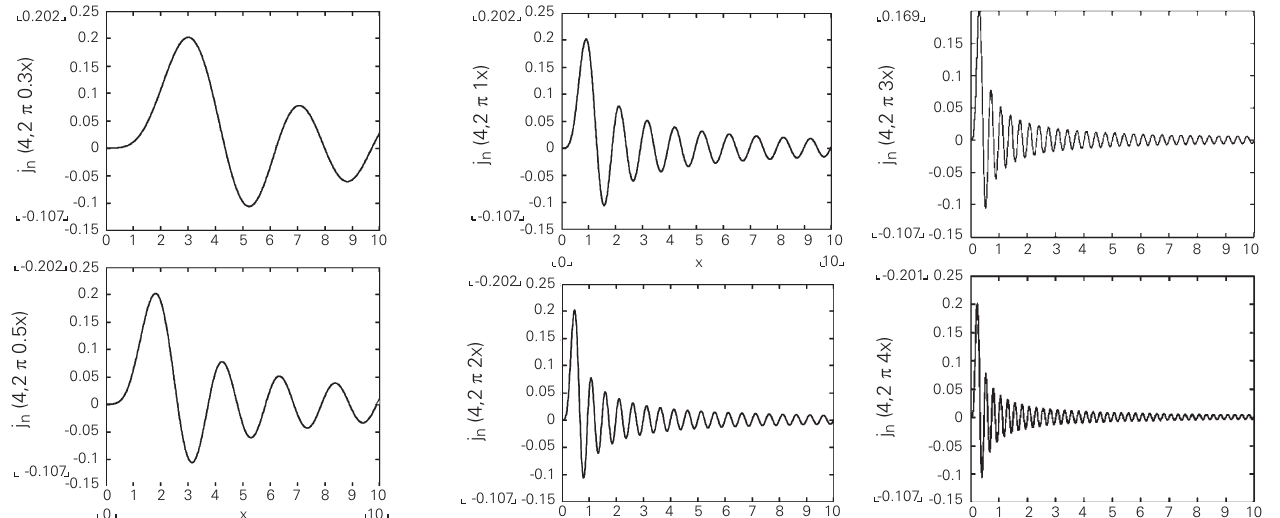
Figure 3. Profiles of spherical Bessel functions, j n (µ), for n = 4, at varying radial frequencies (µ = 0.3x, 0.5x, left; 1x, 2x, center, and 3x and 4x, right).